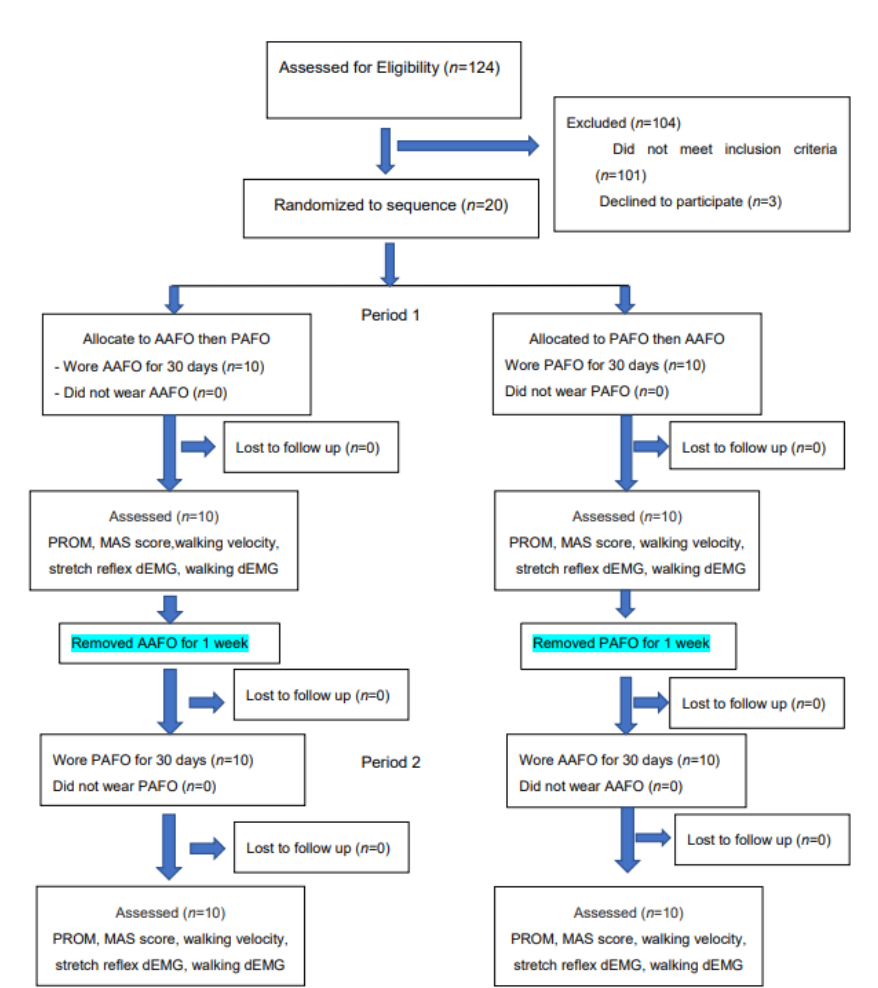
Figure 1. CONSORT flow chart for crossover study. Abbreviations: AAFO, anterior ankle foot orthosis; PAFO, posterior ankle foot orthosis; PROM, passive range of motion; MAS, Modified Ashworth Scale; dEMG, dynamic electromyography.